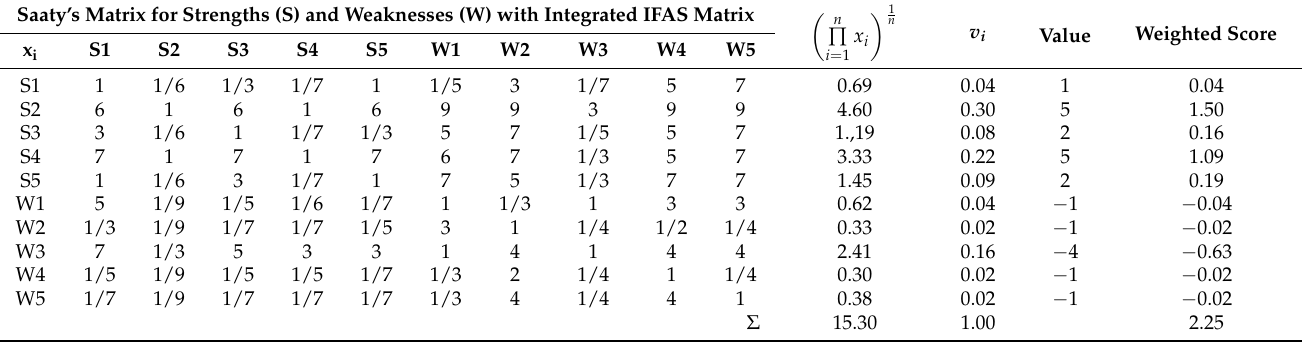
Table 5. Pairs preference using Saaty’s method with integrated internal factors analysis (IFAS) matrix (Source: Own elaboration, 2019).